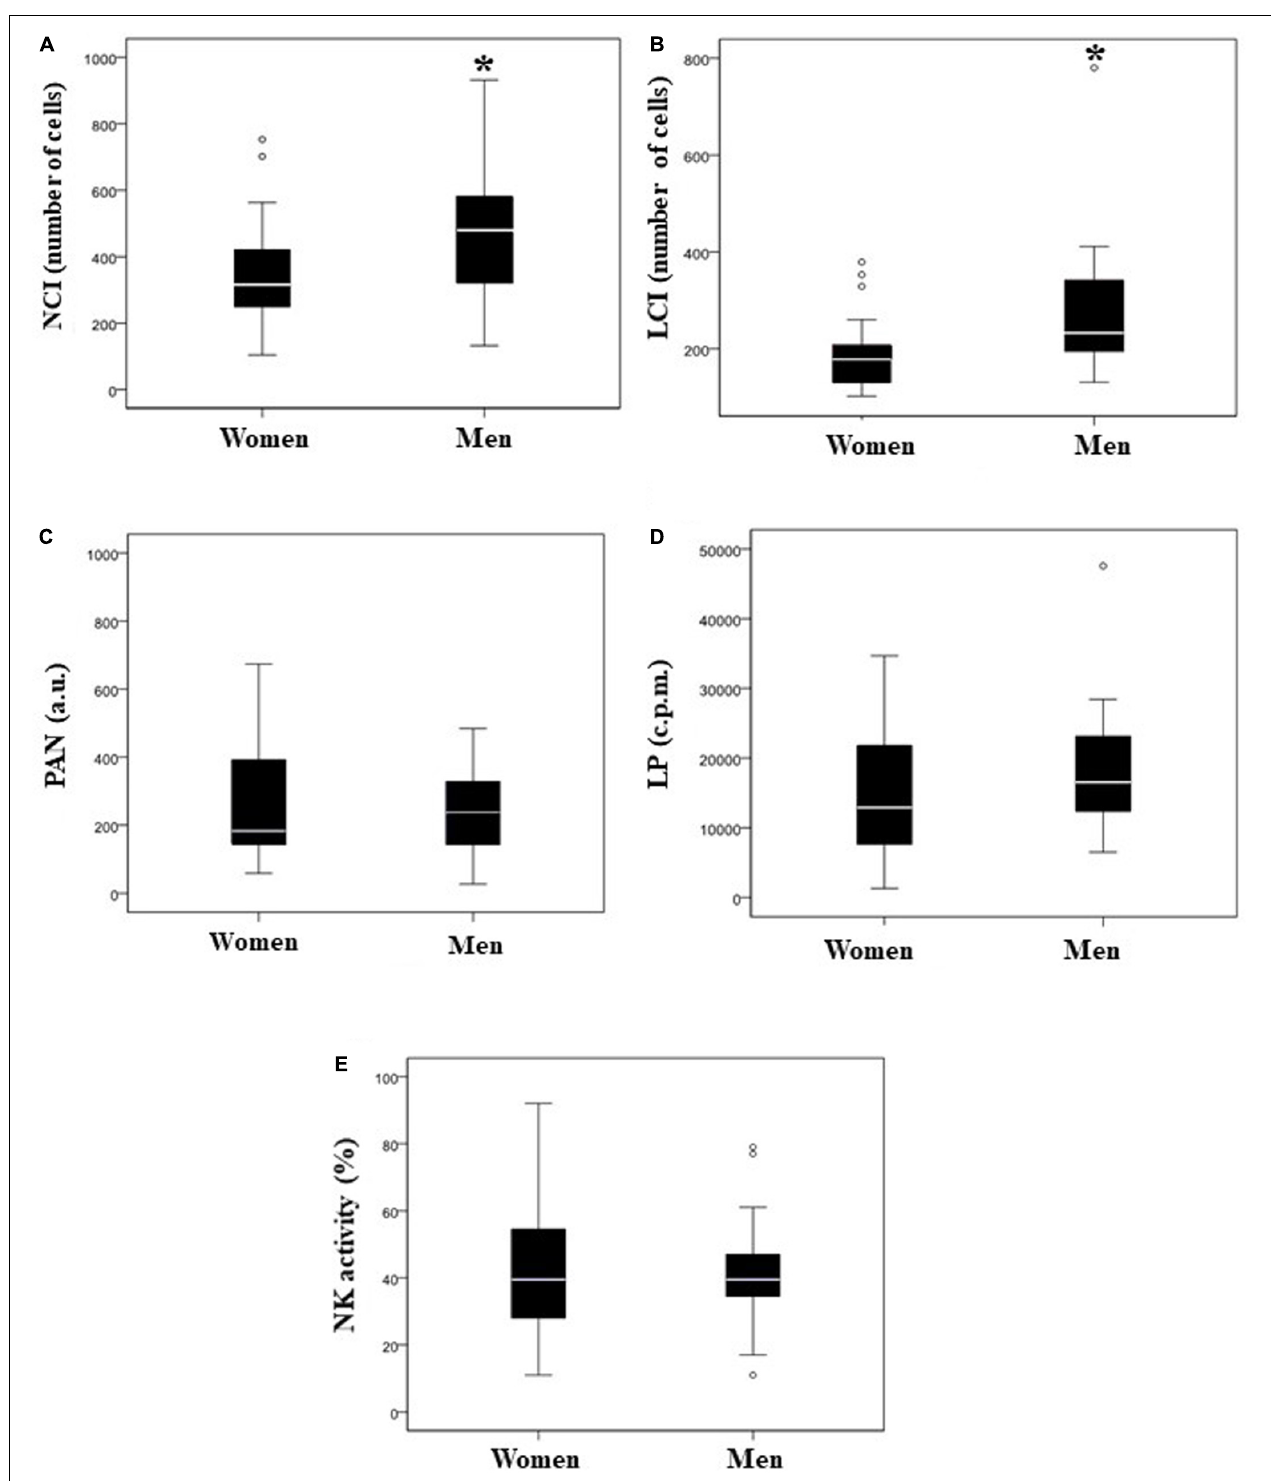
FIGURE 2 | Comparison of immune response in both sexes; box and whisker plots. Neutrophil Chemotaxis Index (NCI; number of cells) (A) , Lymphocyte Chemotaxis Index (LCI; number of cells) (B) , phagocytic activity of neutrophils (PAN; a.u., arbitrary units) (C) , lymphocyte proliferation (LP; c.p.m.) (D) , and natural killer (NK) activity (E) . White bar denotes the median. * p < 0.05 vs.